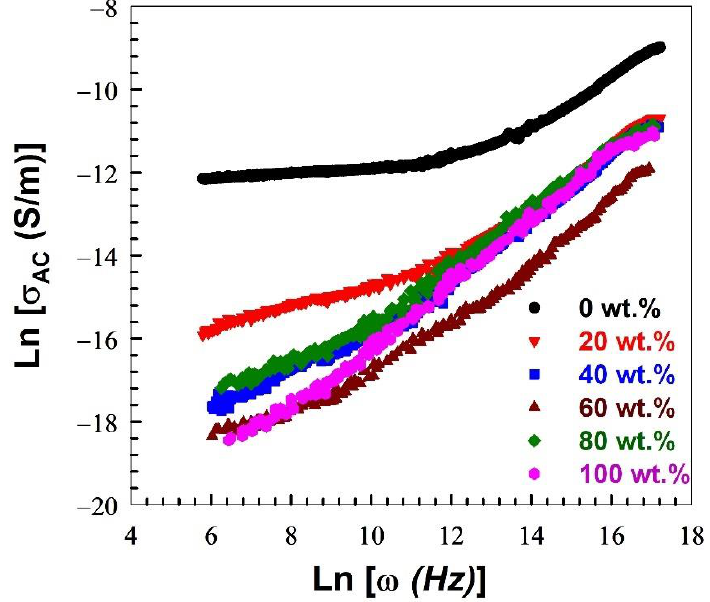
Figure 5. Variation of the ln ( σ ac ) with ln ( ω ) at various Nylon-6,6/PVA blend concentrations.